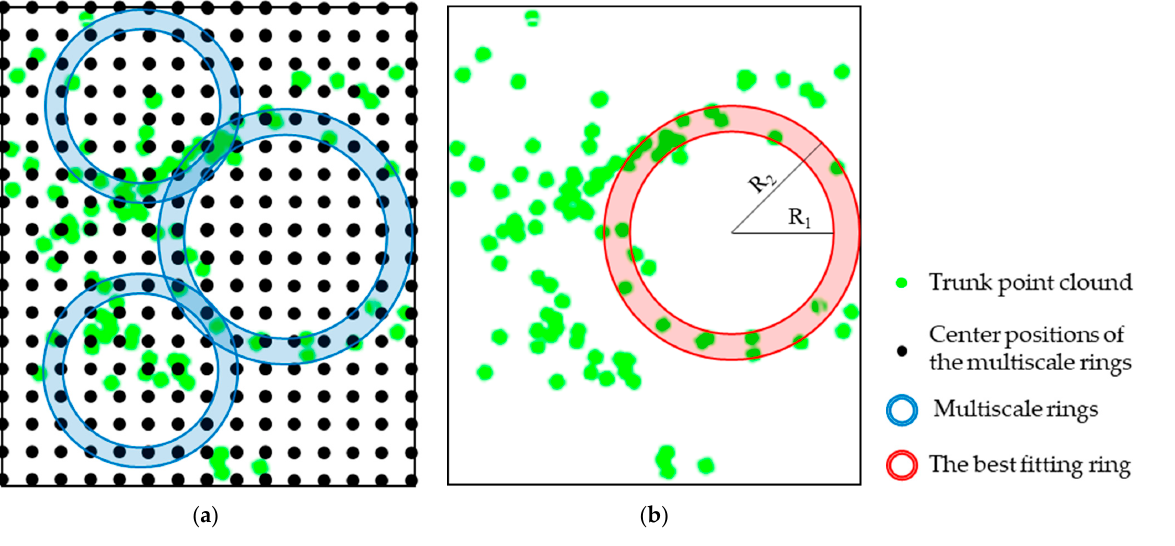
Figure 6. The process of DBH measurement. ( a ) Construction of the multiscale rings and ( b ) deter- mination of the best fitting